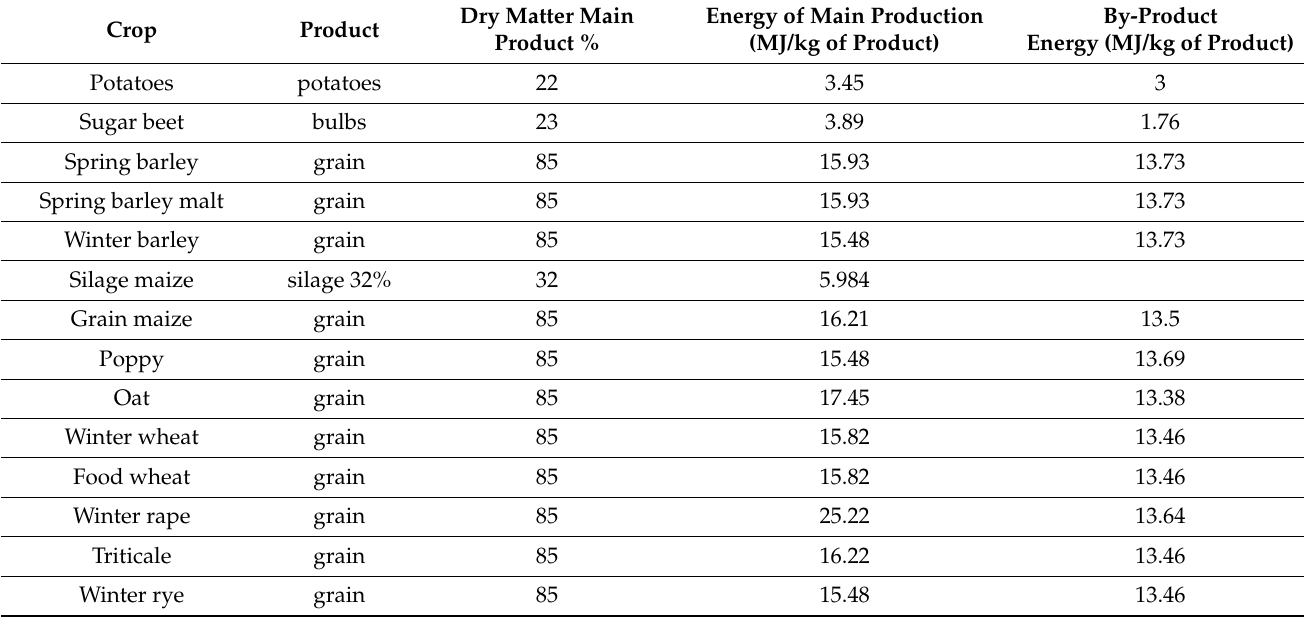
Table A1. Energy of crop production.